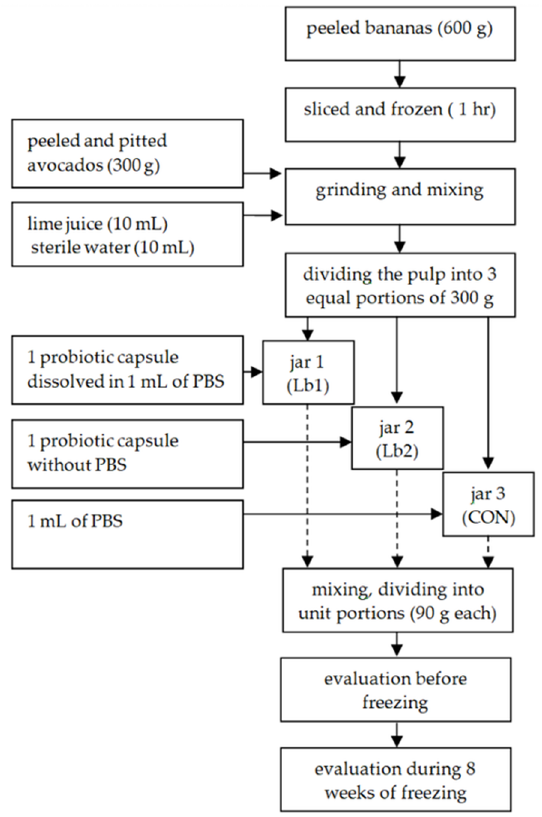
Figure 1. Technological scheme of non-dairy ice cream desserts.